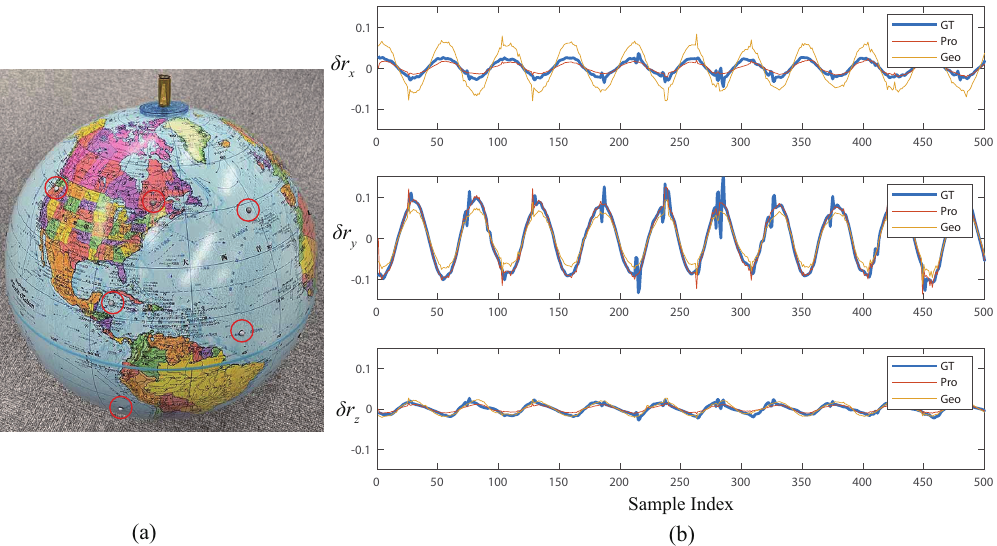
Figure 6. ( a ) Used test globe. Retroreflective markers (red-circled) were attached on the globe to track its rotation. ( b ) Motion-reconstruction results (rotational